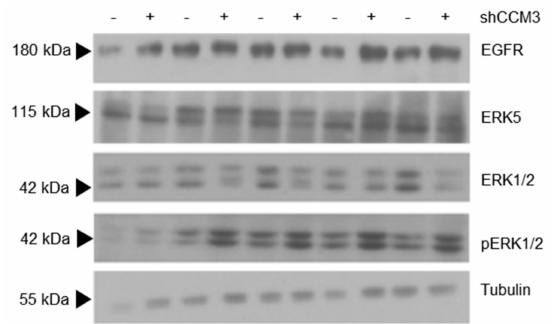
Figure 5. High levels of EGFR in CCM3-deficient cells results in enhanced phosphorylation of ERK1 / 2 after EGF treatment. A549 cells transduced with shNT and shCCM3 shRNAs were serum deprived and treated with 100 ng / mL EGF for the indicated times. EGFR, ERK5, ERK1 / 2 and pERK1 / 2 were analyzed by Western